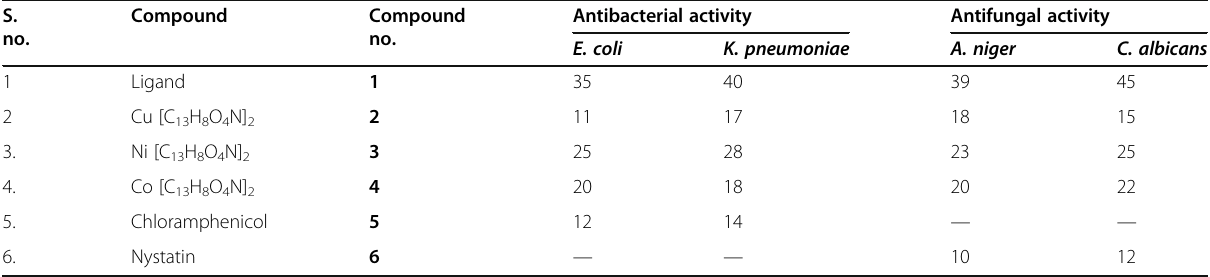
Table 2 Antimicrobial activity (MIC μ g/mL) data